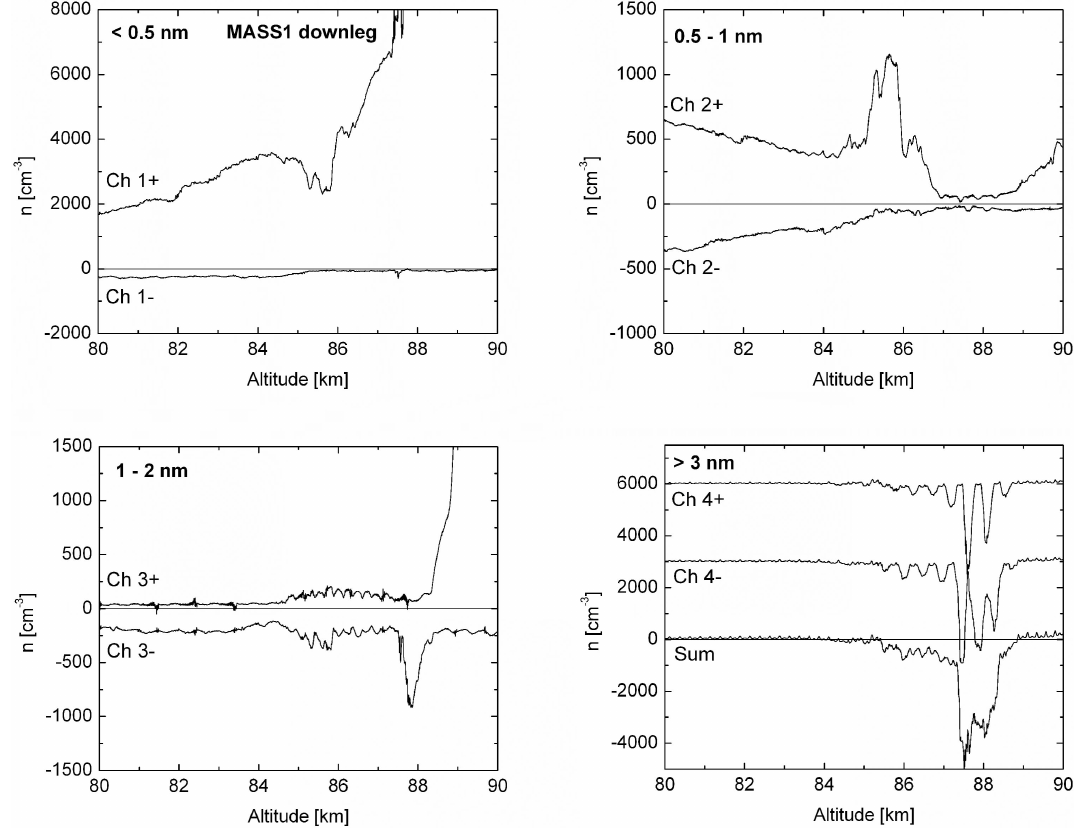
Fig. 7. Data from the 8 channels of the MASS instrument for the downleg of the first flight. Channels 4+ and 4 − are offset from zero for clarity and their sum is plotted